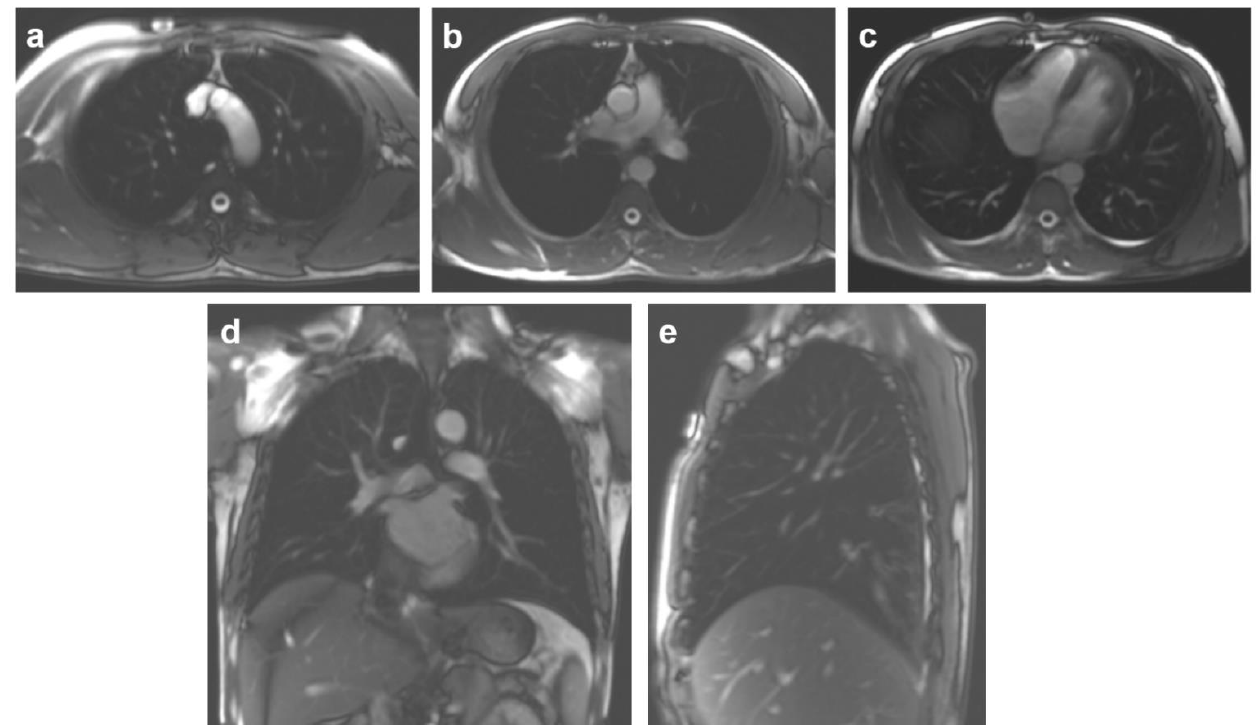
Figure 1. The multiplanar images were acquired on dynamic MRI. The transversal planes including the aortic arch ( a ), tracheal carina ( b ), and the liver apex levels ( c ), a coronal plane through tracheal bifurcation ( d ), and a right sagittal plane passing through the lung apex and diaphragm apex ( e ).